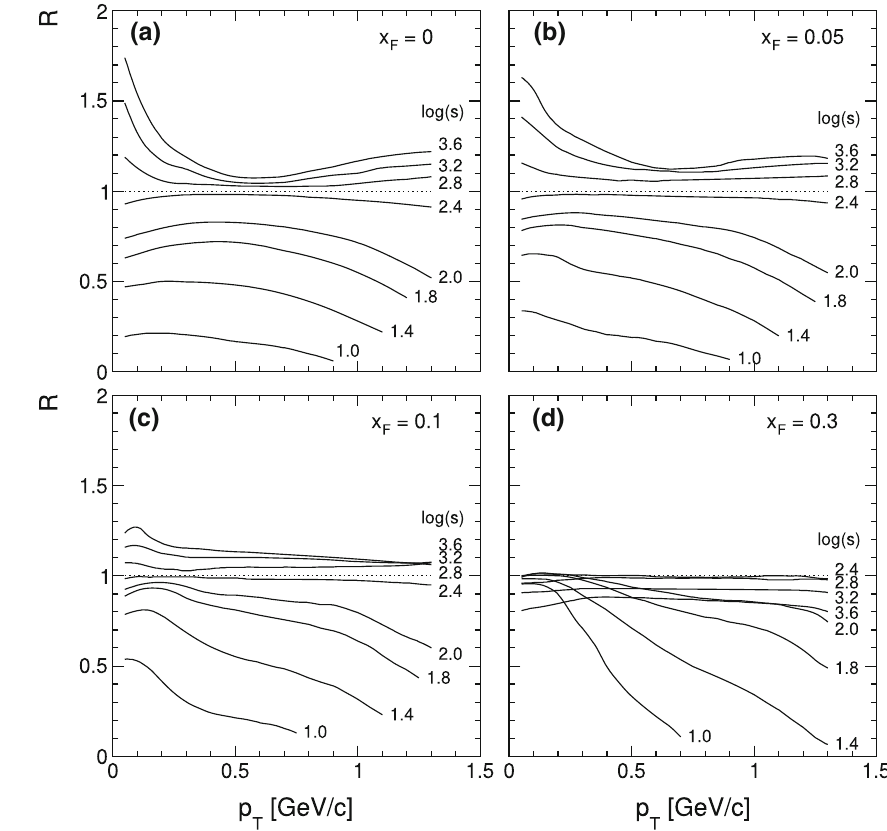
Fig. 179 The ratio R of the invariant π − cross section to the NA49 data (37) as a function of p T for different values of log ( s ) for a x F = 0, b x F = 0.05, c x F =0.1 and d x F =